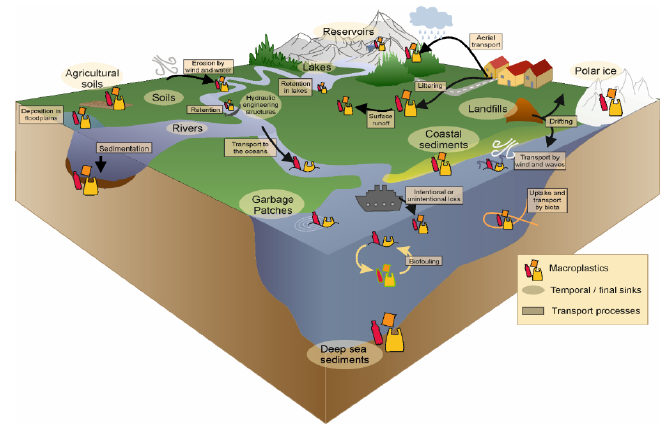
Figure 6. Entry paths, pathways (transport processes), and temporal and final sinks of macroplastic (adapted from [43] and [16]).